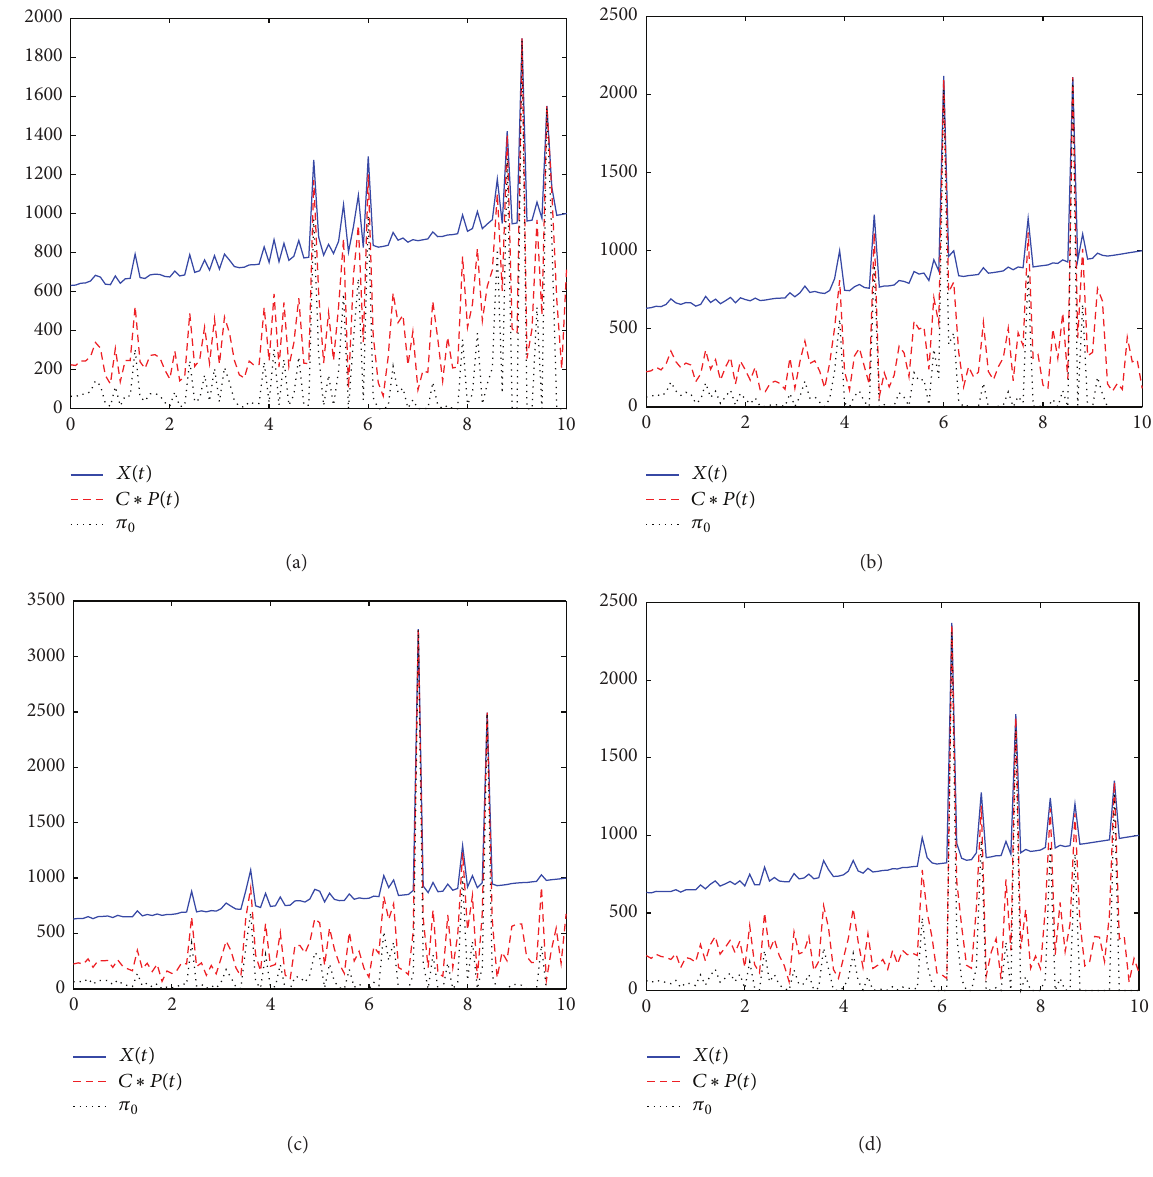
Figure 4: The simulation for the